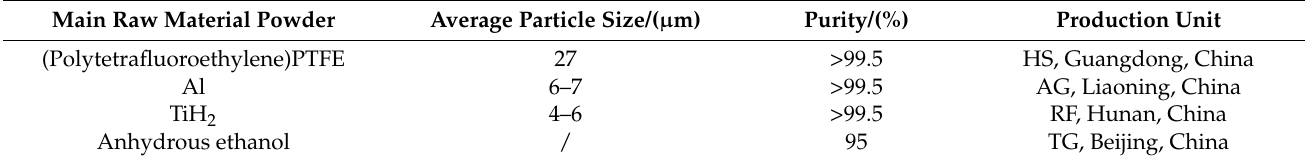
Table 1. Parameters of experimental raw